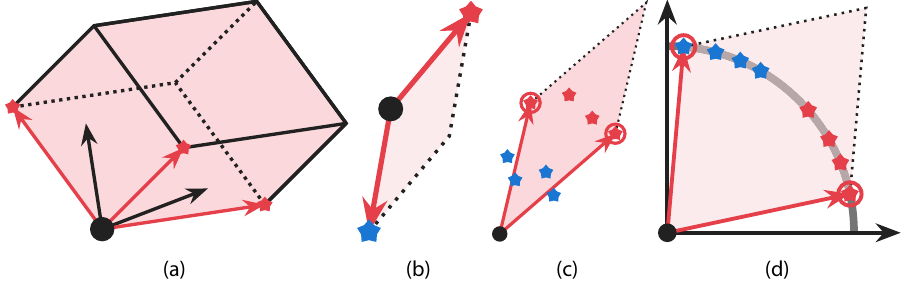
Figure 2. Graphical explanation of ( a ) the log-determinant function, ( b ) the effect of ReLU, and ( c and d ) the effect of normalization. In all figures above, the black dot indicates the origin. ( a ) is a parallelotope spanned by vectors colored in red. ( b ) illustrates an example where the log-determinant function value for dissimilar vectors becomes small if vectors are allowed to have negative elements. Here and in the next two figures, points with different colors (red and blue) represent molecules with dissimilar properties, while those with the same colors have similar properties. ( c ) shows why maximizing the log-determinant function without normalization may result in a non-diverse selection, and ( d ) presents how normalization helps the log-determinant function maximization to select diverse vectors. Note that ( d ) is generally different from the normalized version of ( c ), i.e., vectors generated by the GNN with normalization are different from those obtained by normalizing vectors generated by the GNN without normalization. This is because the backpropagation is performed through the normalization layer, and thus the presence of the normalization layer affects how the GNN parameters are updated. As a result, the GNN is trained to generate molecular vectors so that the task-specific layer can predict molecular properties based on the angles of vectors, as in ( d